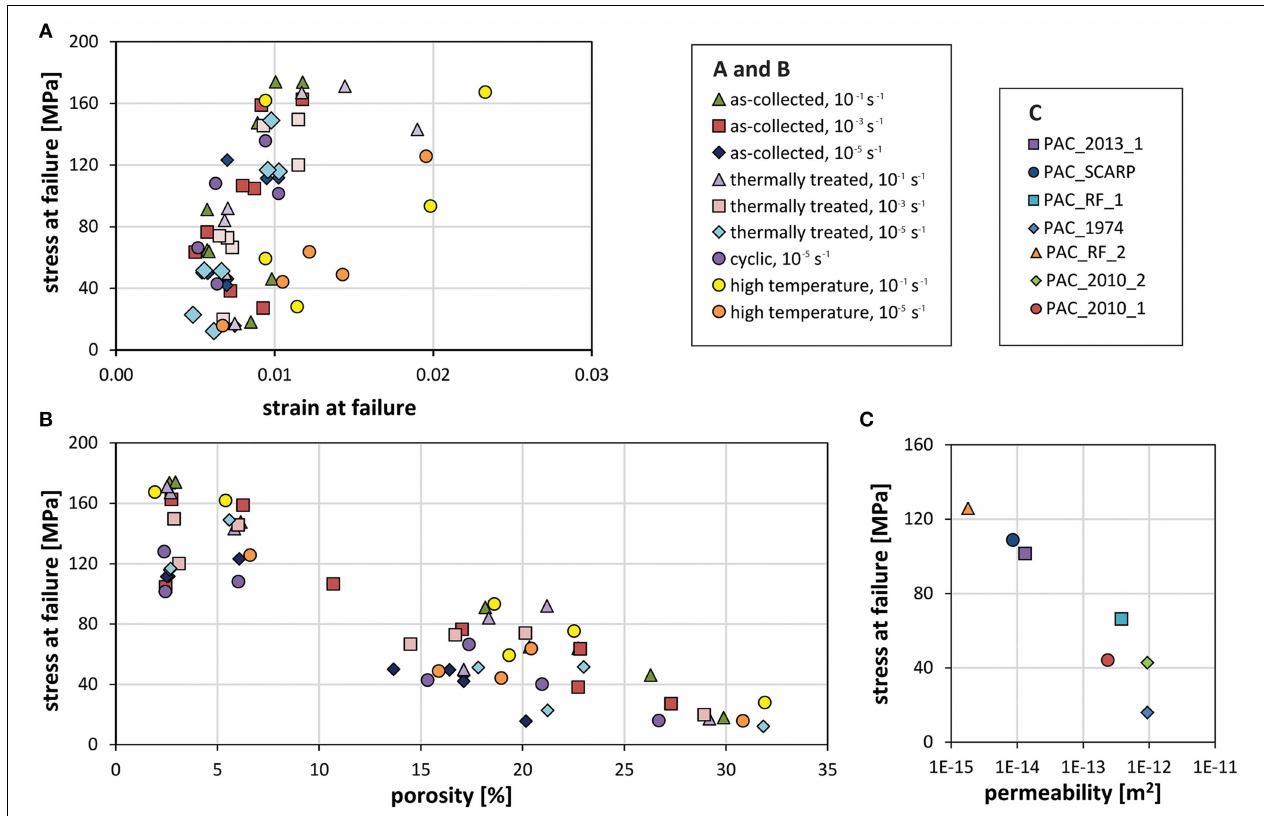
more important during deformation of the densest rocks. The plot also shows that generally the strength of material at high-temperature is higher than that of the rocks (whether original or thermally stressed) deformed at room temperature. (C) The strength of samples shares a linear relationship with the logarithmic of permeability, suggesting that cracks as well as pores influence the strength of these